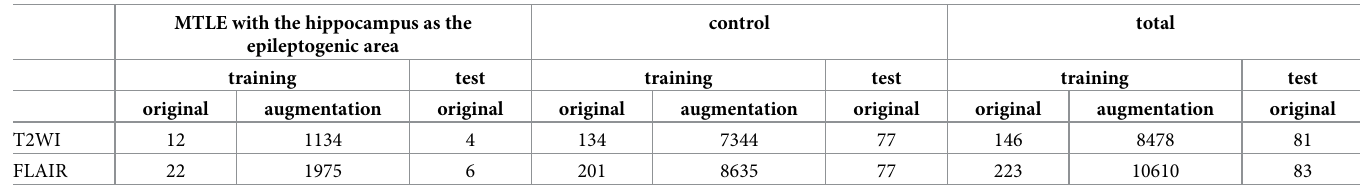
Table 1. Image processing. MTLE with the hippocampus as the epileptogenic